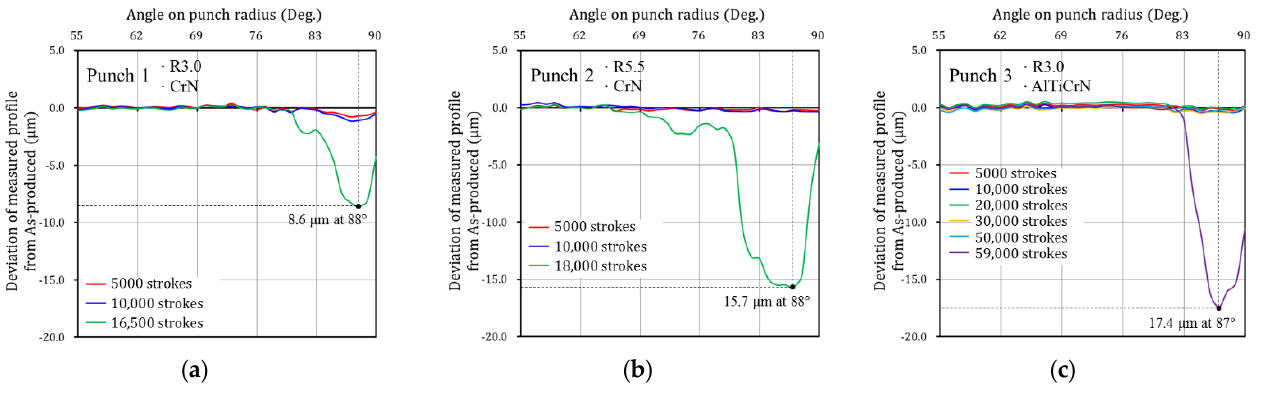
Figure 4. Evolutionary behavior of wear depth on the punch radius with respect to the number of strokes: ( a ) Punch 1 (PVD CrN-coated punch with a radius of 3.0 mm), ( b ) Punch 2 (PVD CrN-coated punch with a radius of 5.5 mm), and ( c ) Punch 3 (PVD AlTiCrN-coated punch with a radius of 3.0 mm).